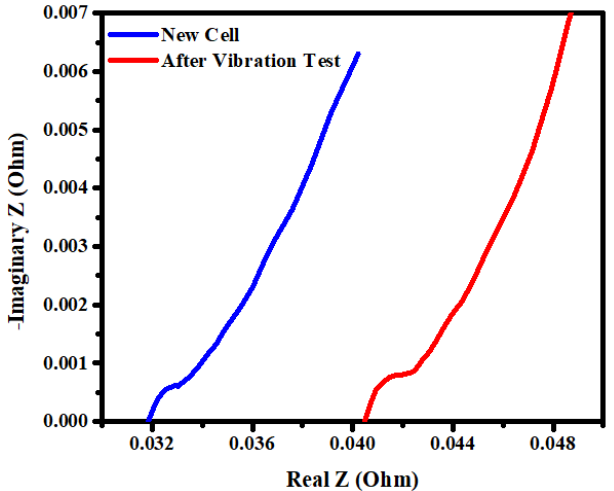
World Electric Vehicle Journal 2019 , 10 , x 10 of 12 Figure 13. Nyquist plot for new cell and cell tested after vibration testing. Figure 13. Nyquist plot for new cell and cell tested after vibration testing.